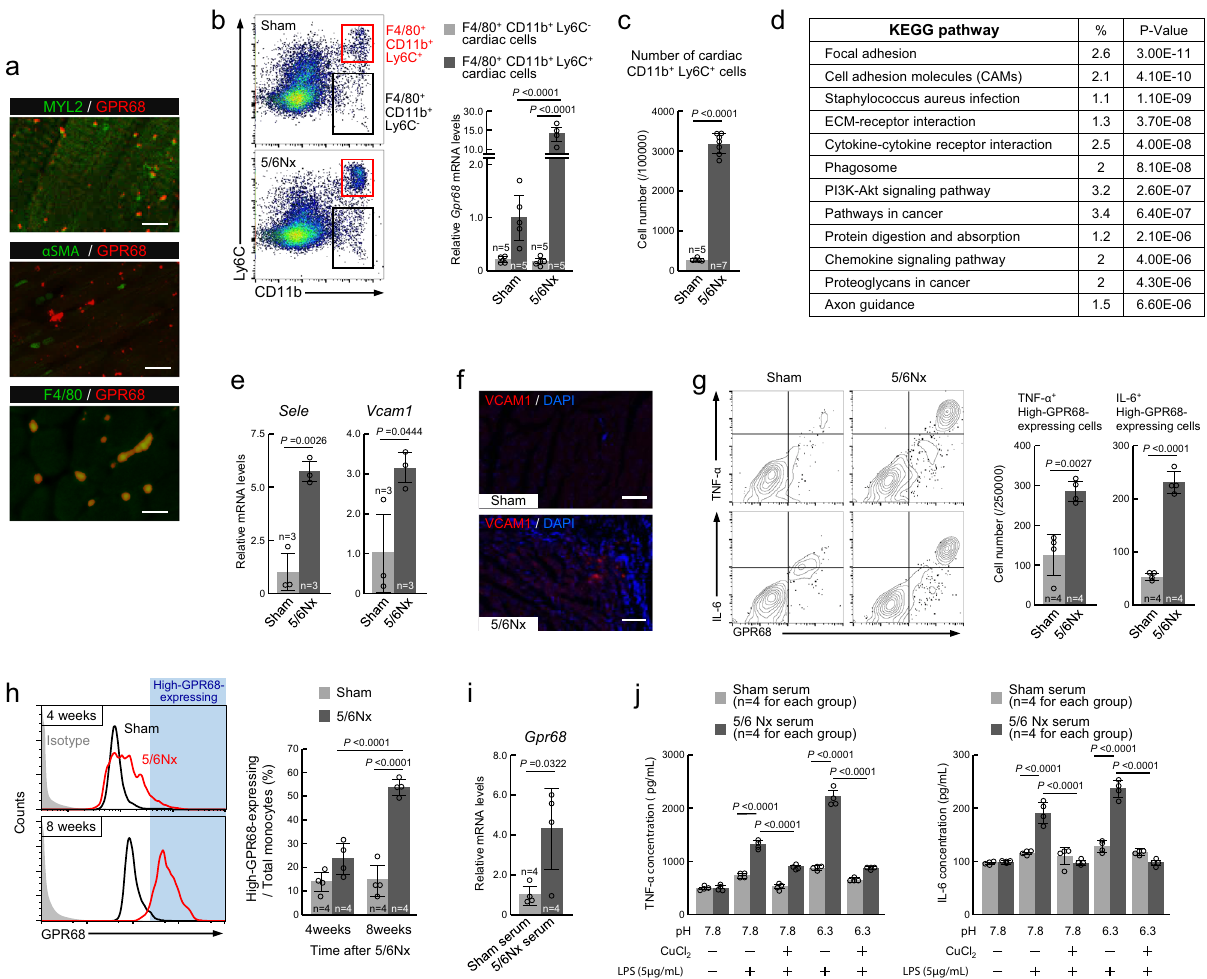
Fig. 2 In fl ammation response of high-GPR68-expressing monocytes in 5/6Nx mice. a Double immuno fl uorescence labeling of GPR68 with MYL2, α SMA, and F4/80 in the cardiac ventricle of 5/6Nx mice. The scale bar indicates 20 μ m. b The expression of Gpr68 mRNA in cardiac macrophages. After separation of F4/80 + /CD11b + cells into Ly6C + and Ly6C − populations, the mRNA levels of Gpr68 in each population were measured by RT-PCR. c Increase in the number of cardiac-in fi ltrated CD11b + /Ly6C + cells in 5/6Nx mice. d Functional analysis of the genes whose expression was changed in the cardiac ventricle of 5/6Nx mice using the KEGG database. e The mRNA levels of Sele and Vcam1 in the cardiac ventricle of 5/6Nx mice. The mean value of the Sham group was set as 1.0. f Immuno fl uorescence labeling of VCAM1 (red) in the cardiac ventricle of Sham and 5/6Nx mice. The scale bar indicates 100 μ m. g The number of TNF α - and IL-6-positive high-GPR68-expressing CD11b + /Ly6C + cells in the cardiac ventricle of Sham and 5/6Nx mice. h The ratio of high-GPR68-expressing monocytes in the blood of Sham and 5/6Nx mice at 4 or 8 weeks after nephrectomy. i The expression of Gpr68 mRNA in primary cultured monocytes after incubation in the media containing 10% serum collected from Sham and 5/6Nx mice. j Release of TNF α and IL-6 from LPS-stimulated monocytes. Primary cultured monocytes were incubated in the media containing 10% serum collected from Sham and 5/6Nx mice for 24 h. Thereafter, cells were incubated in the presence or absence of 5 µ g/mL of LPS and 0.2 mM CuCl 2 under pH 7.8 or 6.3 conditions for 8 h. For i and j , monocytes were isolated from naive ICR mice and serum was collected from individual mice. For all panels, graphs show the mean ± SD of individual mice in independent experiments. Statistical signi fi cance was determined using two-way ANOVA with Tukey – Kramer post hoc tests ( b , h , j ) or two-tailed Student ’ s t -tests ( c , e , g , i ). Numbers and P -values are shown in each graph. Source data are provided as a Source Data fi